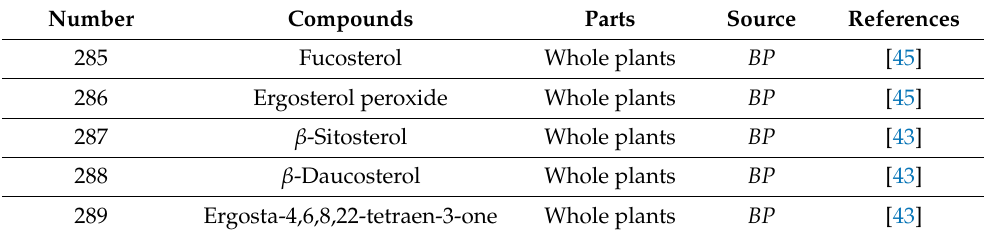
Table 6. Steroids isolated from Broussonetia species.